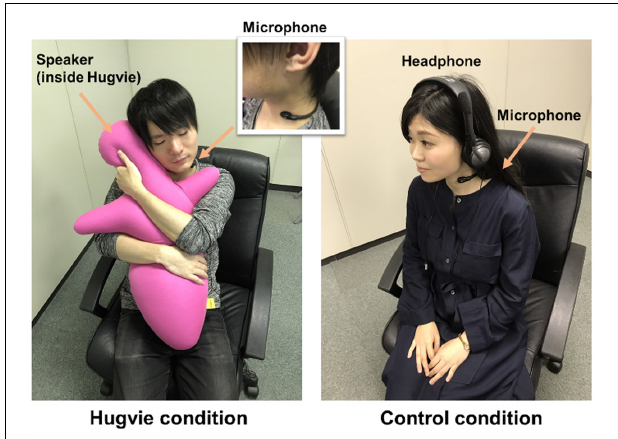
FIGURE 2 | Body posture during experiment in two